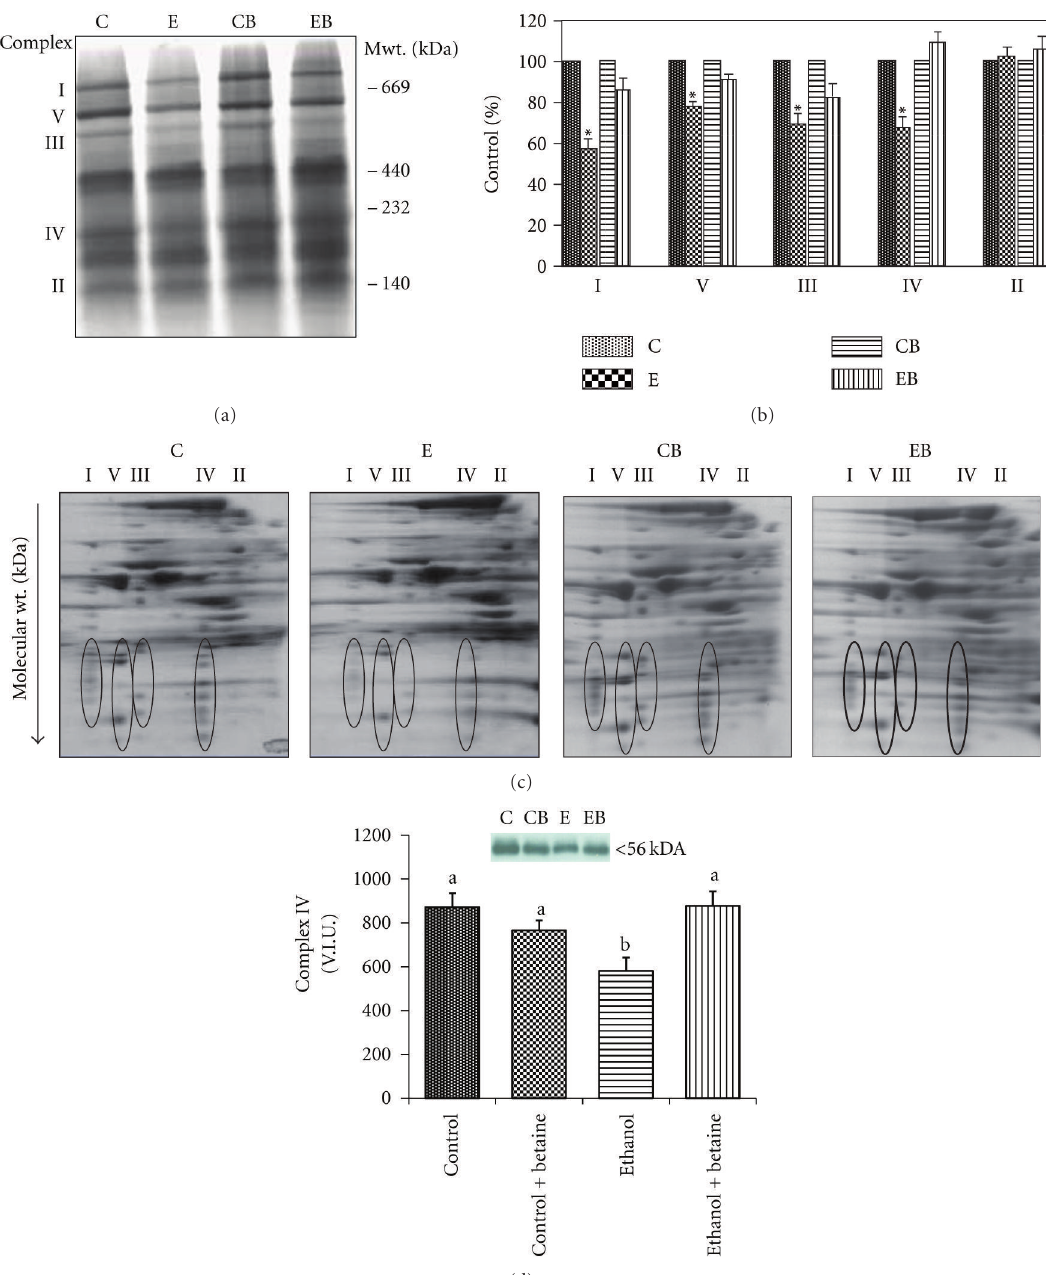
Figure 7: Betaine prevents the chronic ethanol-mediated loss in oxidative phosphorylation proteins. Representative (a) one- and (c) two- dimension blue native (BN)-PAGE proteomic gels of mitochondria isolated from rats fed control, ethanol, control + betaine, or ethanol + betaine diets as detailed in Section 2. (a) For these gels, 250 μ g of mitochondrial protein were subjected to 1D BN-PAGE. (c) The 1D gel strips were overlaid across a Tris-Tricine-SDS-PAGE gel to resolve the individual polypeptides that comprise each oxidative phosphorylation system complex. The proteins that comprise each complex (I, V, III, IV, and II) appear as vertically aligned spots on the 2D gel. (b) Comparison of the relative quantities of complexes I, V, III, and IV in liver mitochondria from the control; control + betaine; ethanol, and ethanol + betaine. Statistical analyses for data presented in panel B: 2-factor ANOVA on raw densitometry values—complex I: ethanol P = 0 . 0002, betaine P = 0 . 92, interaction P = 0 . 02; complex V: ethanol P = 0 . 016, betaine P = 0 . 72, interaction P = 0 . 23; complex III: ethanol P = 0 . 005, betaine P = 0 . 92, interaction P = 0 . 31; complex IV: ethanol P = 0 . 15, betaine P = 0 . 62, interaction P = 0 . 045; complex II: ethanol P = 0 . 54, betaine P = 0 . 98, interaction P = 0 . 80. (d) Complex IV, subunit 1 protein levels were measured by immunoblotting. The bar graph results represent the mean volume integration units (V.I.U) ± S.E.M. for n = 8 animals per group. Values not sharing a common letter are statistically di ff erent, P < 0 . 05. The top figure shows representative immunoblots of subunit 1 protein for control, ethanol, and betaine supplemented control and ethanol-fed